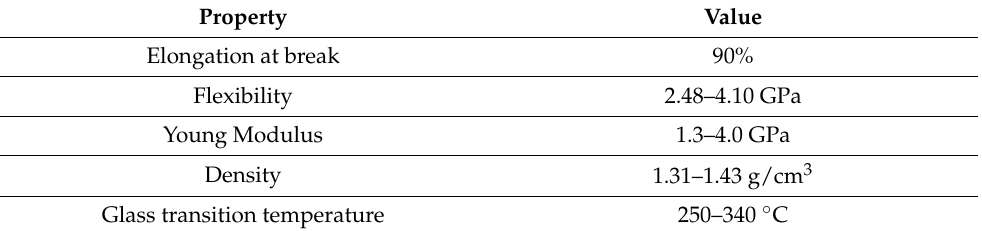
Table 4. PIs’ relevant properties